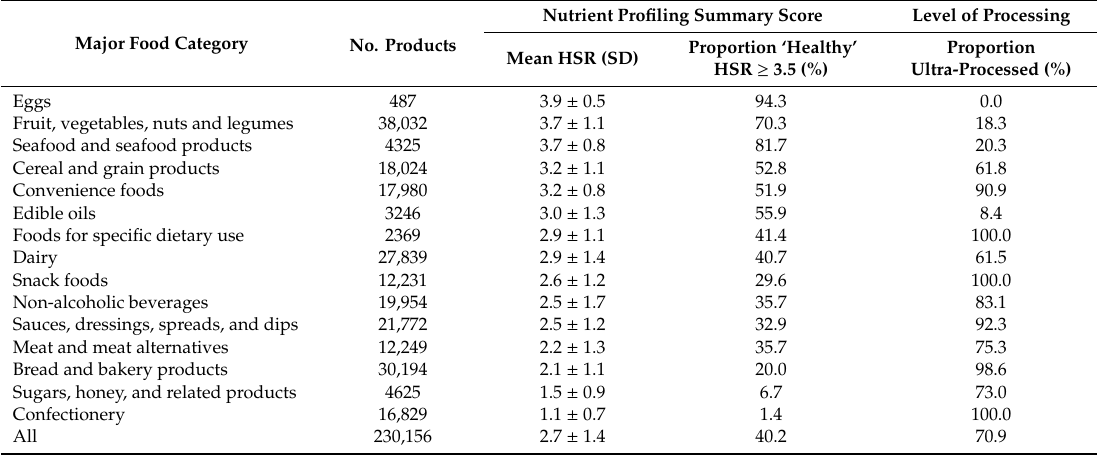
Table 1. Healthfulness of the US food and beverage supply by major food